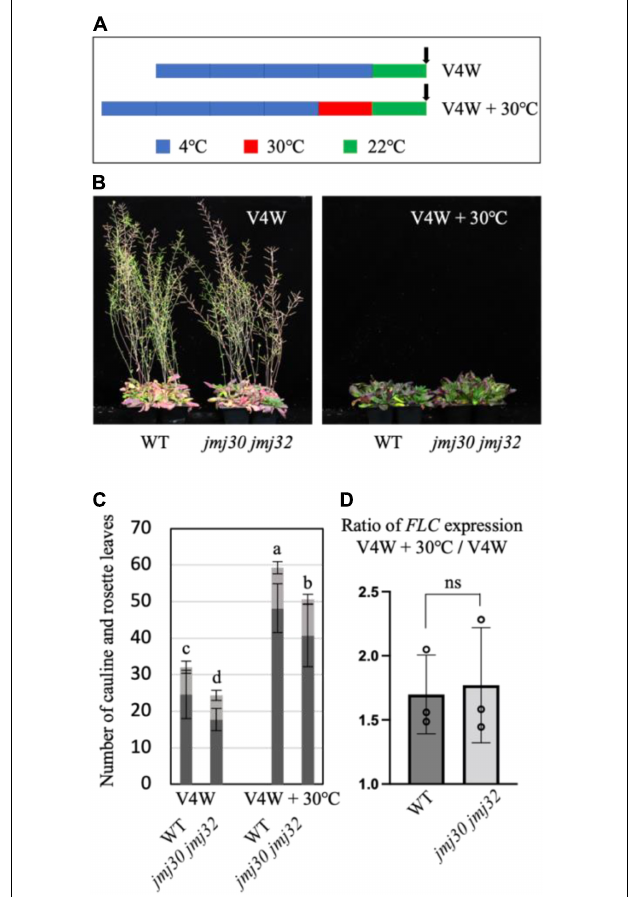
FIGURE 5 | Devernalization occurred in jmj30 jmj32. (A) Schematic diagram of the experimental conditions. For the vernalized conditions (V4W), we incubated the seeds at 4 ◦ (blue) after water absorption and then cultivated them for a week at 22 ◦ (green) followed by sampling for RNA extraction. For devernalized conditions (V4W + 30 ◦ C), after vernalization, we transferred the plate at 30 ◦ in the dark (red) and then cultivated it at 22 ◦ . (B) Photographs of wild type and jmj30 jmj32 in vernalized conditions (left) and devernalized conditions (right). (C) Quantification of the number of cauline (gray) and rosette (black) leaves of wild-type and jmj30 jmj32 plants under vernalized conditions (left) and devernalized conditions (right). Error bars represent SD. One-way ANOVA followed by the Tukey–Kramer test was performed ( p < 0.05). Different letters indicate significant differences, while the same letters indicate non-significant differences. (D) The ratio of FLC expression between V4W + 30 ◦ C and V4W. ns, not significant (Student’s t